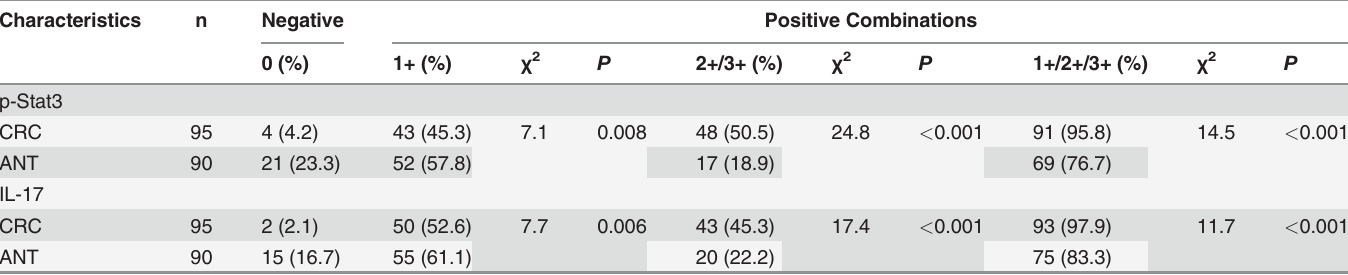
Table 4. More CRC Tissues Show Strong Positive Stainings (2+/3+) of Constitutive p-Stat3 and Expressed IL-17 than ANT Tissues.